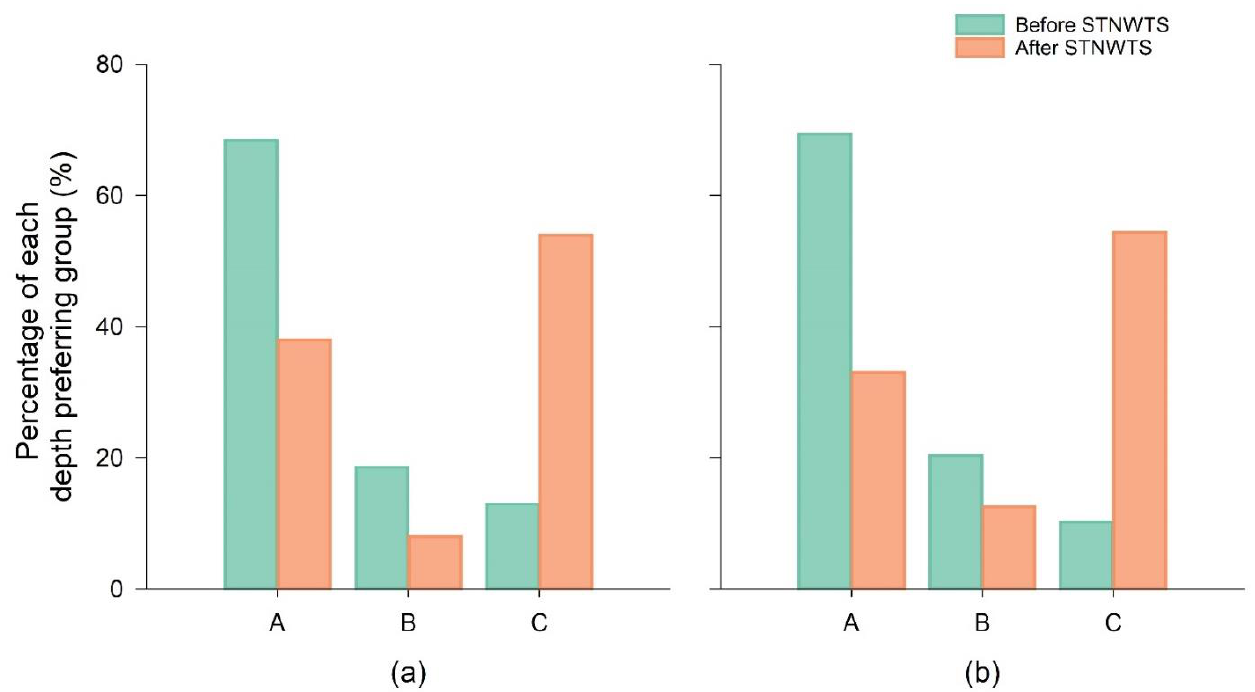
Figure 5. The percentage of each depth preferring group during the two study periods: ( a ) spring migratory season; ( b ) autumn migratory season. A: shallow-water preferring group, with threshold depths all below 0.6 m; B: moderate-depth-water preferring group, with threshold depths between 0.9 – 7 m; C: deep-water preferring group, with threshold depths over 10 m.